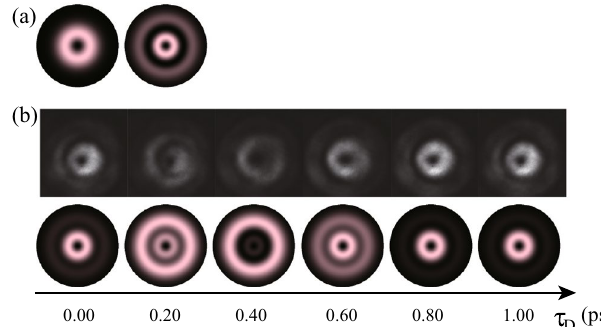
1 OV pulses with the = 1 . ( b ) The 0 and p 2 1 with ℓ = = =